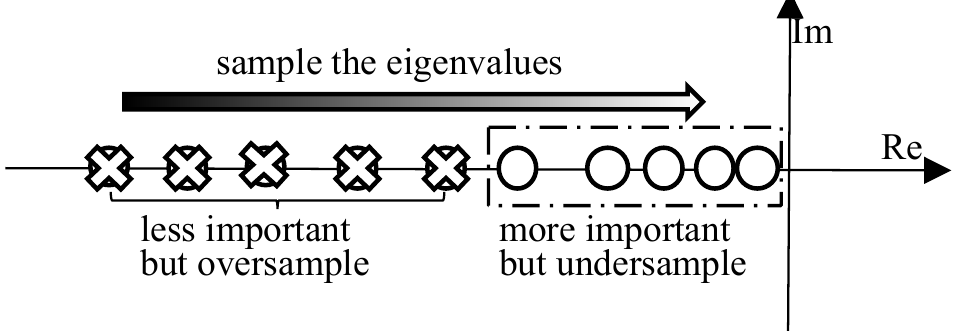
Figure 3. Sampling regions of spectrum in ordinary Krylov subspace